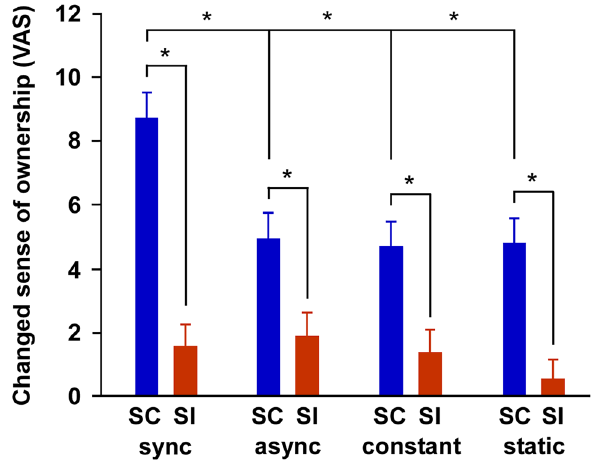
Figure 2. Temporal and spatial congruencies markedly increased a changed sense of ownership. The results of ownership sense. All spatial congruency (SC) conditions increased the changed sense of ownership compared to spatial incongruency (SI) conditions (* p < 0.05). Synchronization condition (sync) increased the changed sense of ownership compared to the conditions of asynchronization (async), constant speed (constant), and static (* p < 0.05). Error bars show the standard error of the